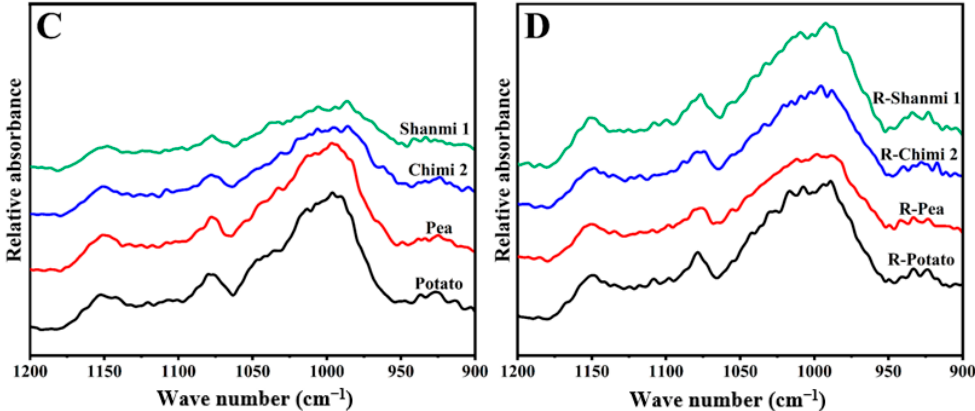
Figure 3. ( A ) X-ray diffraction patterns of natural starch (NS); ( B ) X-ray diffraction patterns of resistant starch (RS); ( C ) Ordered structure (FTIR) of natural starch (NS); ( D ) Ordered structure (FTIR) of resistant starch (RS).